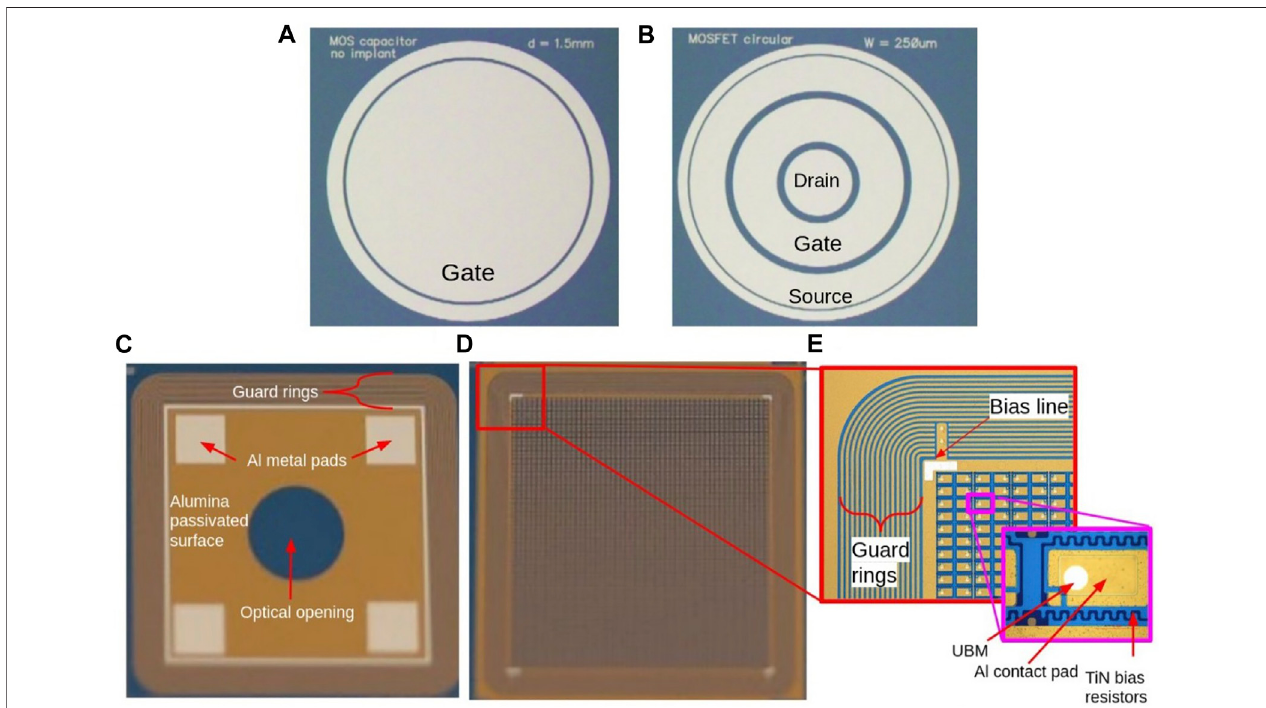
FIGURE 1 | Measured samples: (A) MOS capacitor, (B) MOSFET, (C) Pad diode, (D) AC-coupled pixel sensor with metal bias implants, and (E) showing zoomed and detailed structures within the pixel detector.